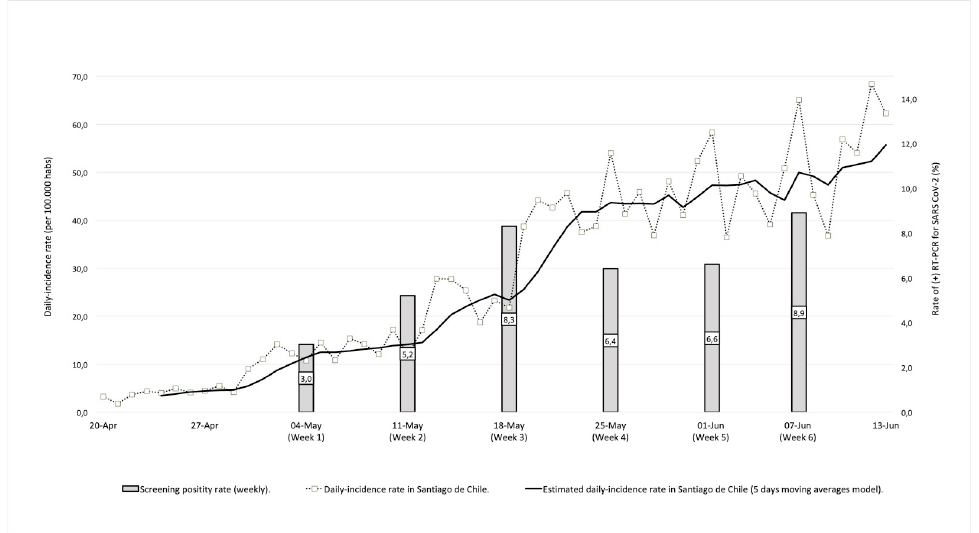
Fig 1. Screening performance per study week related to daily case incidence in Santiago de